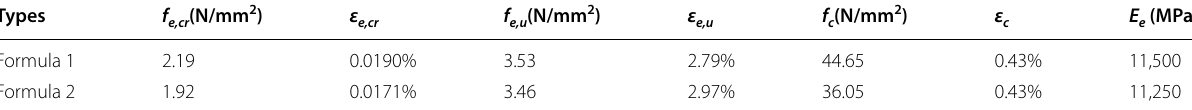
Table 3 Test results of ECC material properties.